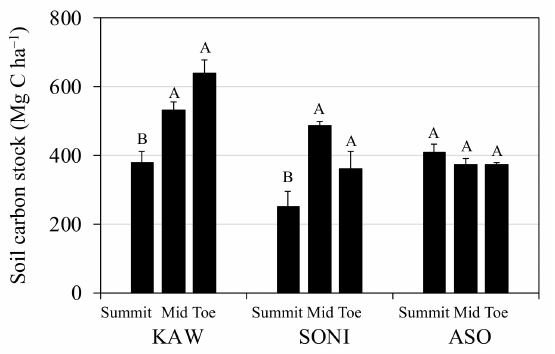
Figure 2. Profile summary of mean soil carbon stock along three catenas at semi-natural Miscanthus sinensis grassland sites in Japan (i.e., Kawatabi Field Science Center, Miyagi Prefecture (KAW); Soni Plateau, Nara Prefecture (SONI); Aso-Kuju National Park, Kumamoto Prefecture (ASO)). Error bars represent the standard errors. Statistically different means within a site are noted by means separation letters ( p <